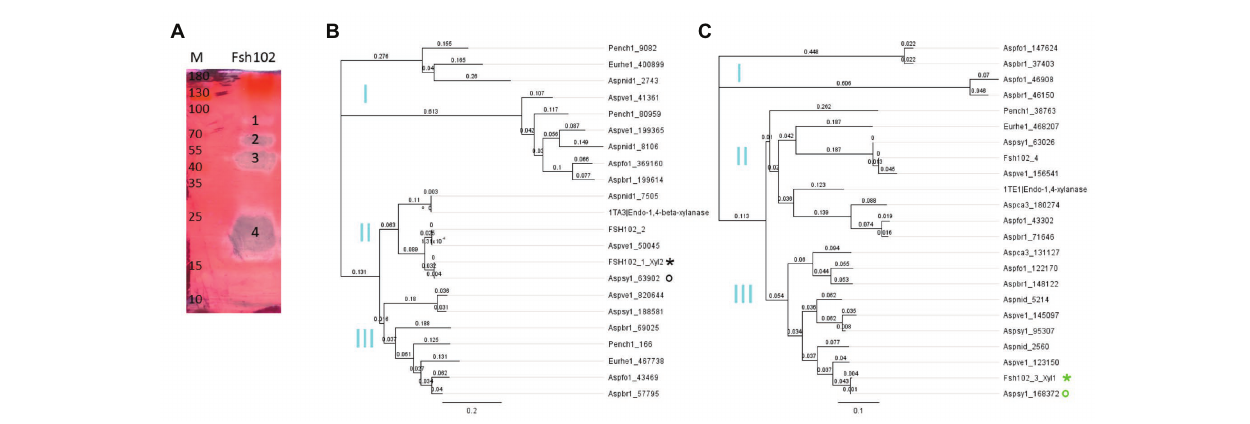
FIGURE 2 | (A) Zymogram of xylanase activity using the supernatant of the Fsh102 fungal strain separated by a 12.5% (w/v) SDS-PAGE containing 0.5% (w/v) xylan. The xylan in the gel was stained with 0.1% (w/v) Congo red. Fsh102: the total supernatant of the fungal isolate Fsh102 after 24 h incubation in 1% (w/v) xylan medium. The areas with xylanase activity (1–4) remain unstained. M: Page Ruler Plus Prestained Protein Ladder. The molecular weights of the standard are given in kDa. (B,C) Phylogenetic trees of amino acid sequences of selected members of the GH10 (B) or GH11 (C) families. The global alignment was performed with free end gaps and the cost matrix Blosum62 was used with genetic distance model Jukes-Cantor. The gene are from the JGI MycoCosm. Aspbr1, Aspergillus brasiliensis ; Aspfo1, Aspergillus luchuensis formally known as Aspergillus foetidus ; Aspnid1, Aspergillus nidulans ; Aspsy1, Aspergillus sydowii ; Aspve1, Aspergillus versicolor ; Aspca3, Aspergillus carbonarius formally known as Aspergillus aculeatus ; Eurhe1, Eurotium rubum ; and Pench1, Penicillium chrysogenum . The gene identified are behind the underline. From the Protein Data Bank (PDB), a candidate for the GH10 or GH11, respectively, was used 1TA3 an 1,4- β -xylanase GH 10 from Aspergillus nidulans for the Xylanase II or 1TE1 an Endo-1,4- β -xylanase GH 11 from Penicillium funiculosum . For the Fsh102 two candidates are added per GH family (FSH102_1 to FSH102_4), while xylanase II = FSH102_1_Xyl2 (black star) and xylanase I = FSH102_3_Xyl1 (green star). The primers were deduced from the sequences marked with the circles, while the green one was used for the xylanase I or the black for the xylanase II, respectively. Subclades (I–III) are marked in